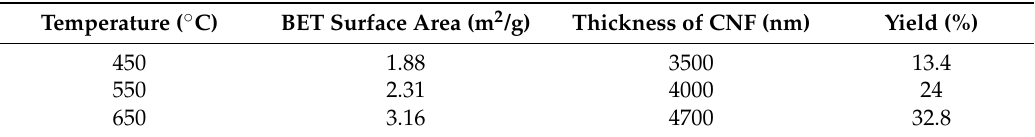
Table 2. Surface area and yield of resulting CF-CNF at different growth temperature by use of 100 mM catalyst concentration for 30 min under 50 sccm acetylene flow rate.